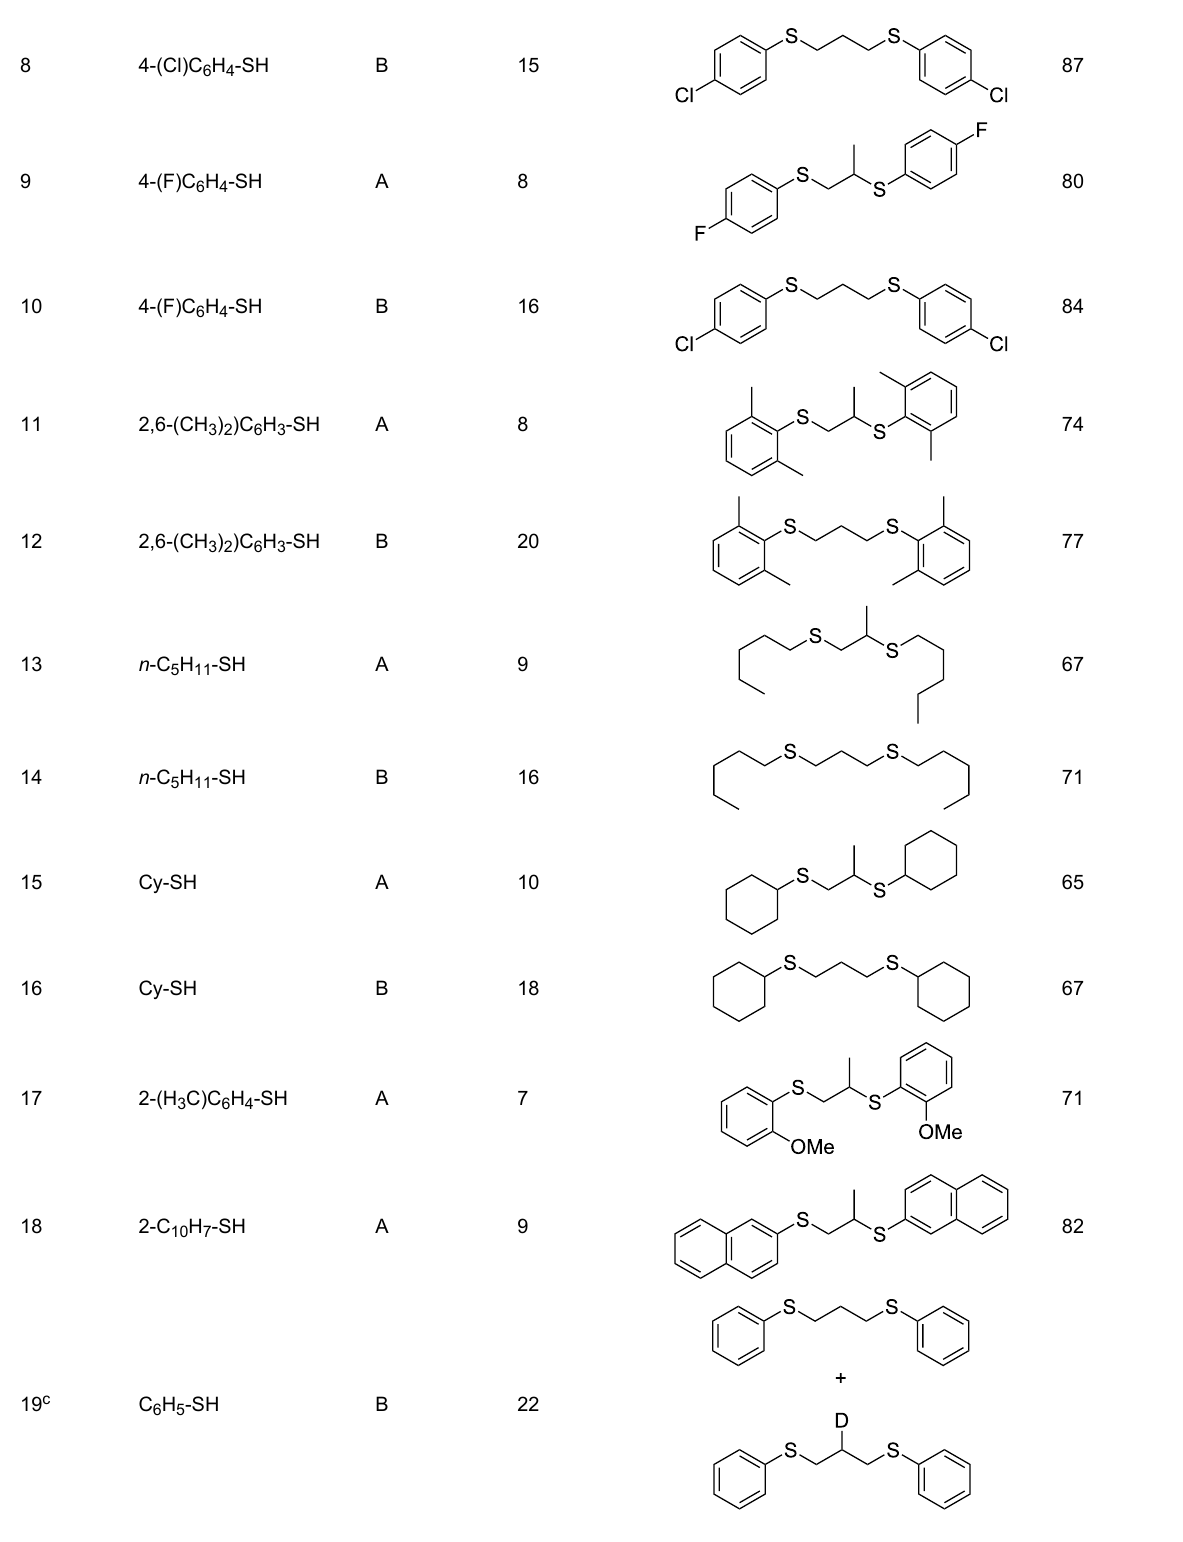
Table 2: Regioselective one-pot synthesis of 1,2 and 1,3-dithioethers using dry (pre-calcined) or moistened silica gel at room temperature.